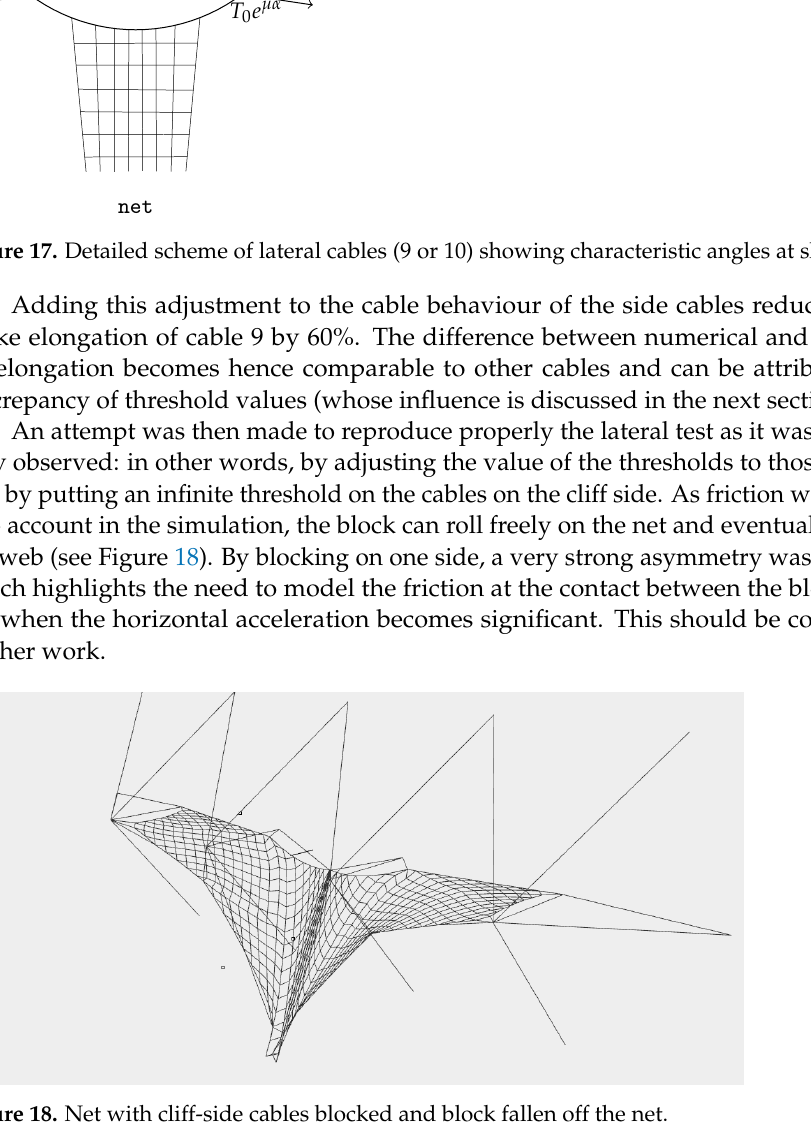
Figure 18. Net with cliff-side cables blocked and block fallen off the